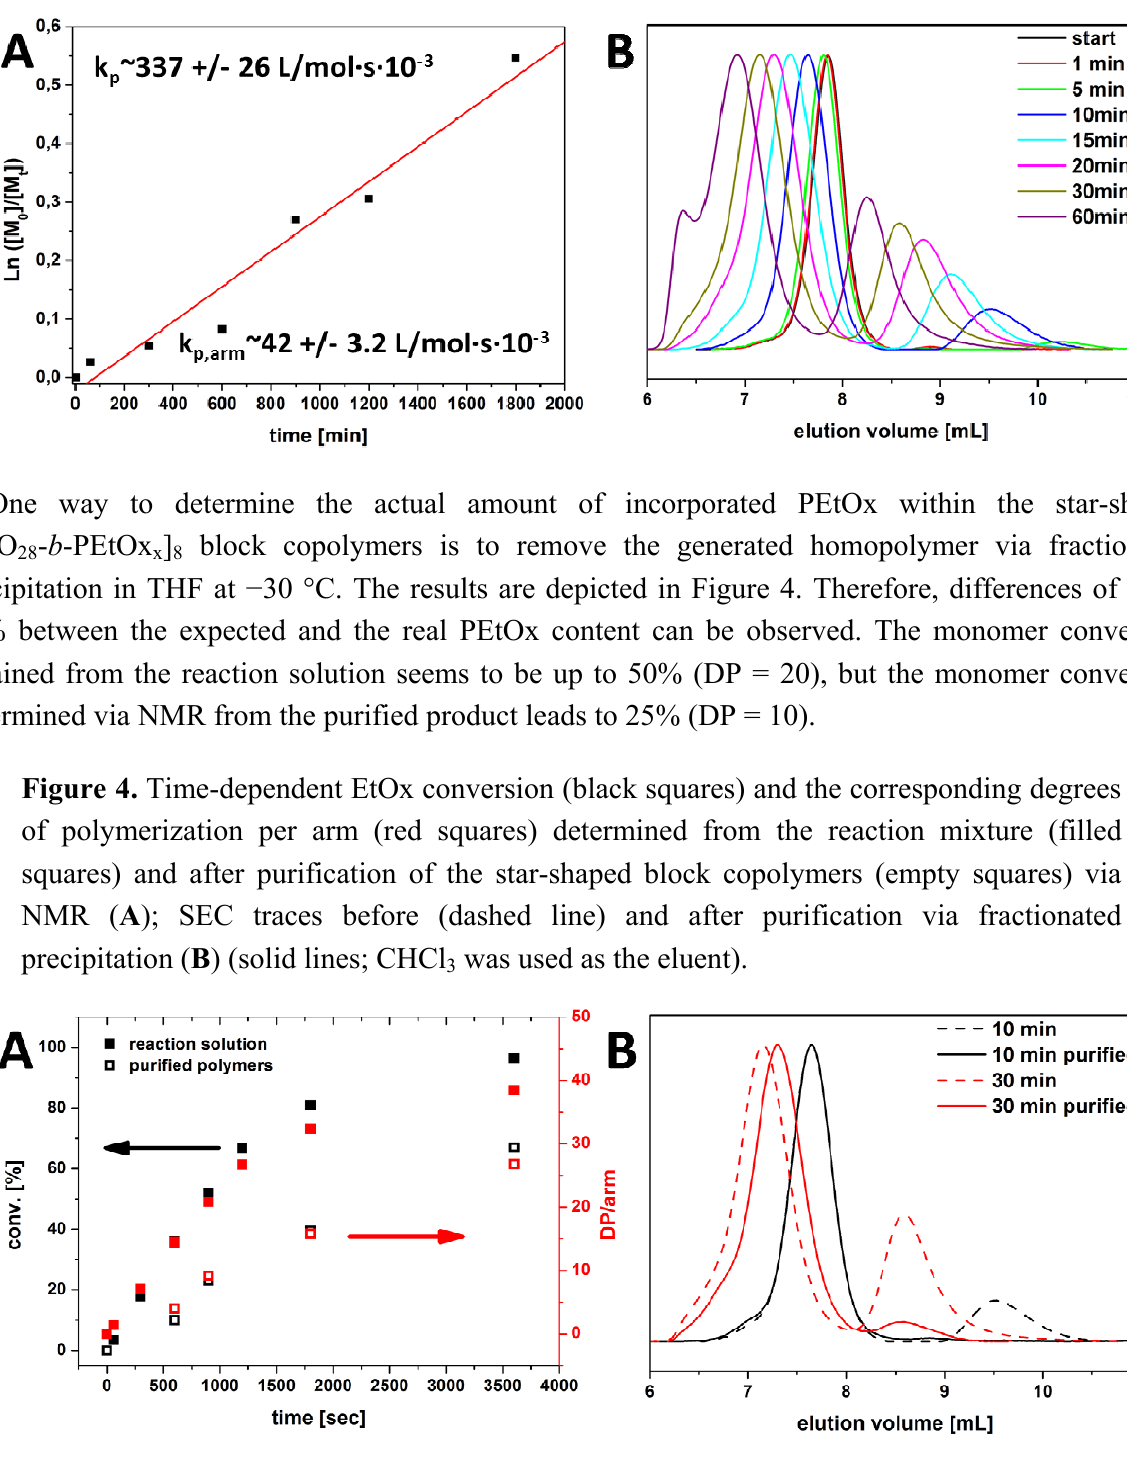
Figure 3. First order time-conversion plot for the kinetic investigation of the microwave assisted polymerization of EtOx with [PEO comparison of the time-dependent SEC traces (CHCl